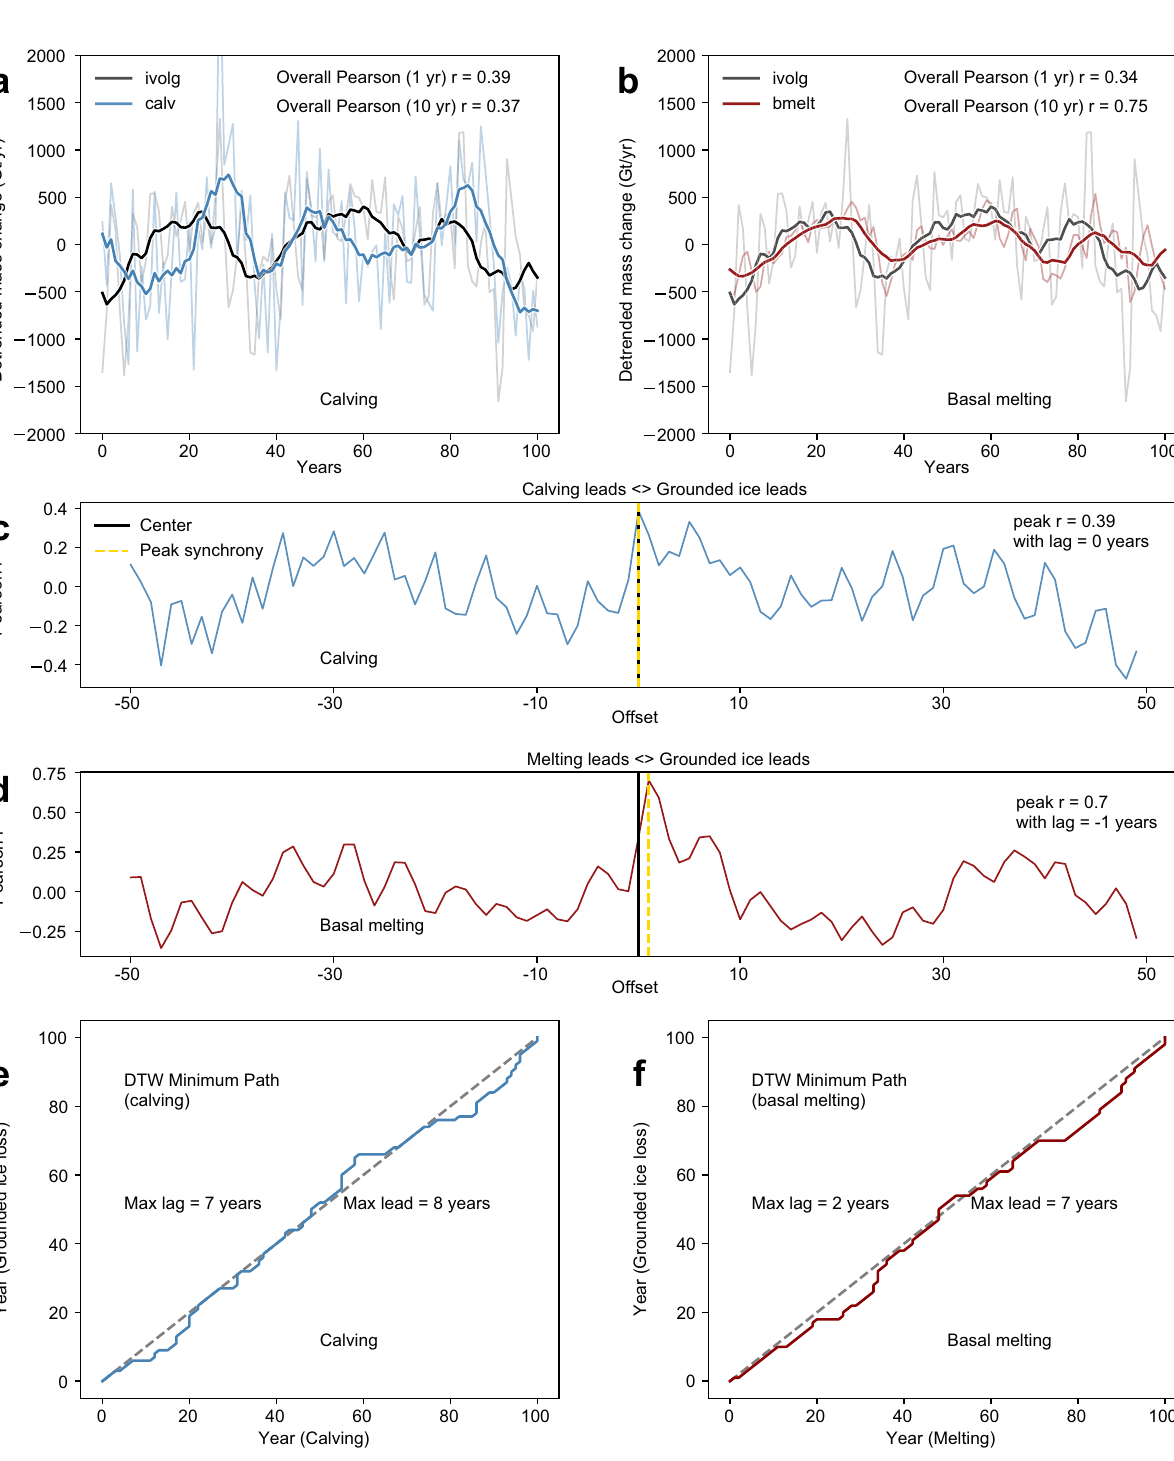
Fig. 4 Modeled relation between iceberg calving, sub-shelf melt, and change in grounded ice mass. a Correlation between linearly detrended annually resolved and domain-integrated changes in modeled rate of calving loss and the rate of change of the volume of grounded ice (faint lines), and the same analysis for a 10-year fi ltered timeseries of the same data (bold lines). b The same analysis, but showing correlations between ice shelf basal melt rate and grounded ice volume. Faint lines show annual data, bold lines show 10-year fi ltered data. Note that colored lines in a and b give rate of change (in Gt/yr) and refer to total volume of grounded ice (ivolg), calving fl ux (calv), and fl ux from sub-ice shelf melting (bmelt). c Correlation coef fi cients for calving and d melting for a range of lead and lag magnitudes, up to 50 year. e Dynamic time warp (DTW) analysis showing time-varying offset between strongest point- wise correlations of calving or f melting with ice sheet volume